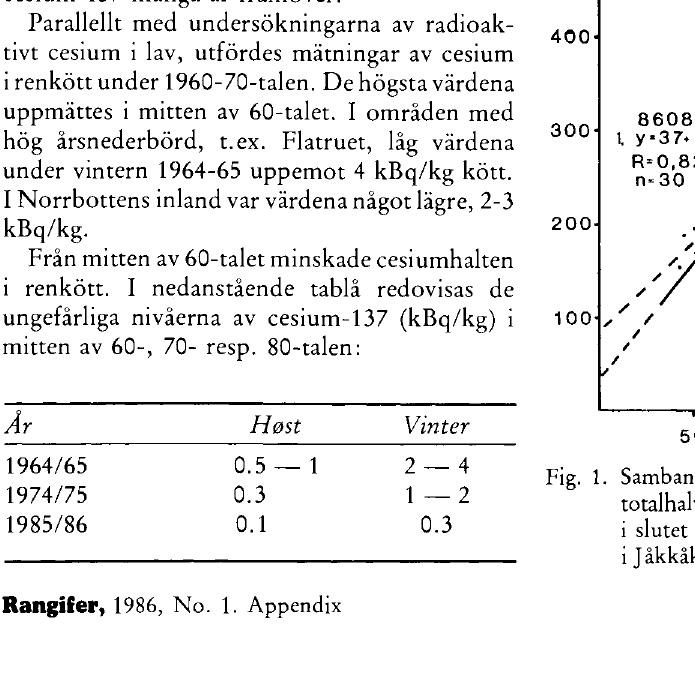
Fig. 1. Sambandet mellan halten cesium-134 (X) och totalhalten cesium-137 (Y) i renkott vid slakt i slutet av augusti resp. borjan av september i Jåkkåkaska